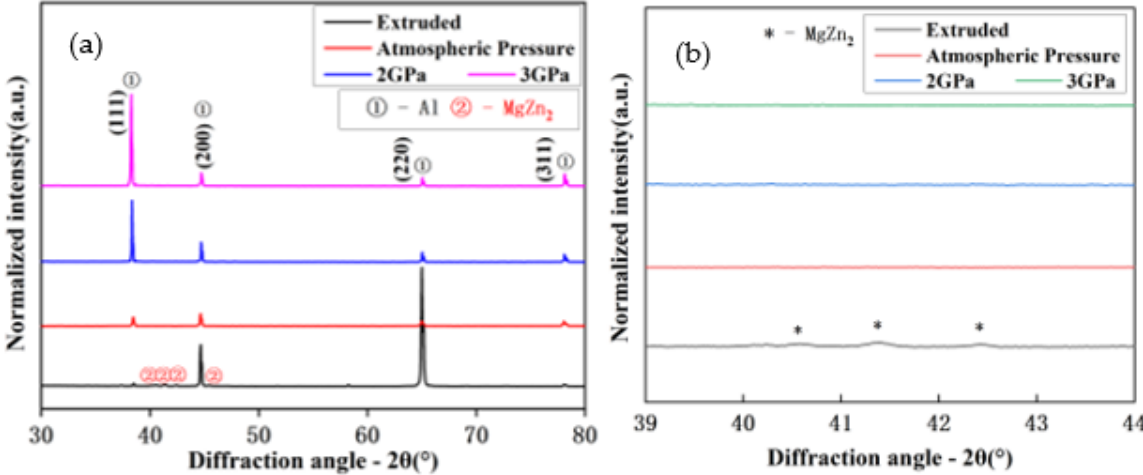
Figure 2. The X-ray diffraction patterns of the ( a ) extruded Al-Zn-Mg-Cu-based alloys annealed at different pressures (atmospheric pressure 1 and 2 GPa) and ( b ) plot showing the presence of MgZn 2 phase.